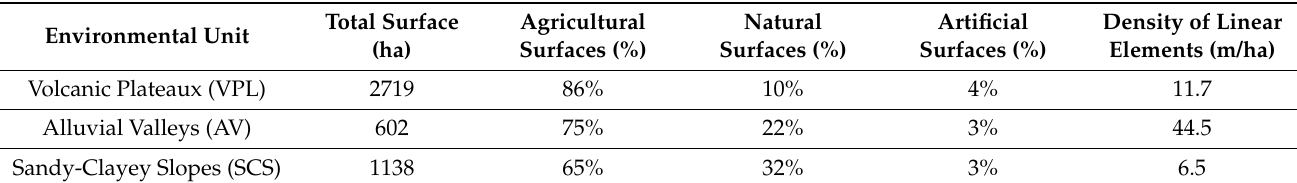
Table 1. Landscape features (percent coverage of main land cover types and density of linear woody elements) of the EUNs occurring in the Marcigliana Nature